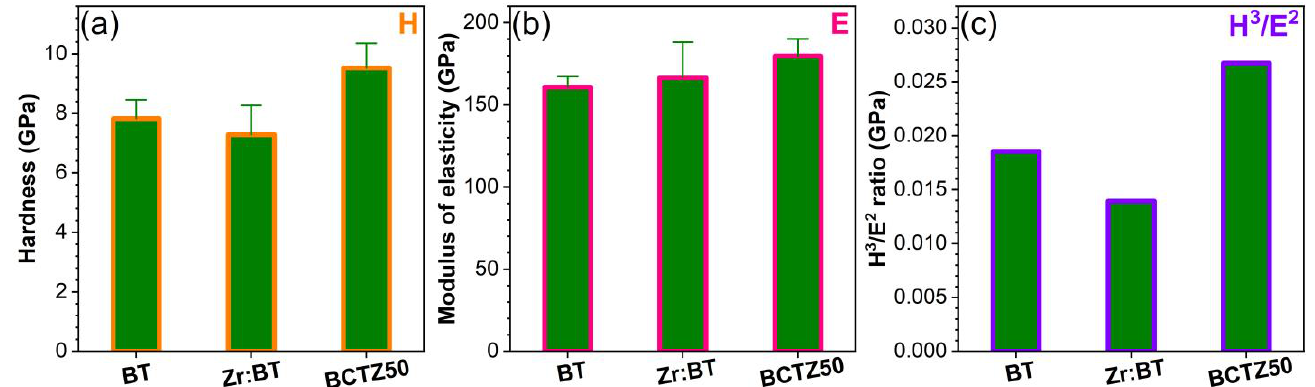
Figure 7. ( a ) Hardness; ( b ) modulus of elasticity; and ( c ) H 3 /E 2 ratio (“plastic index”) determined for the BT, Zr:BT and BCTZ50 sintered ceramics based on indentation tests.